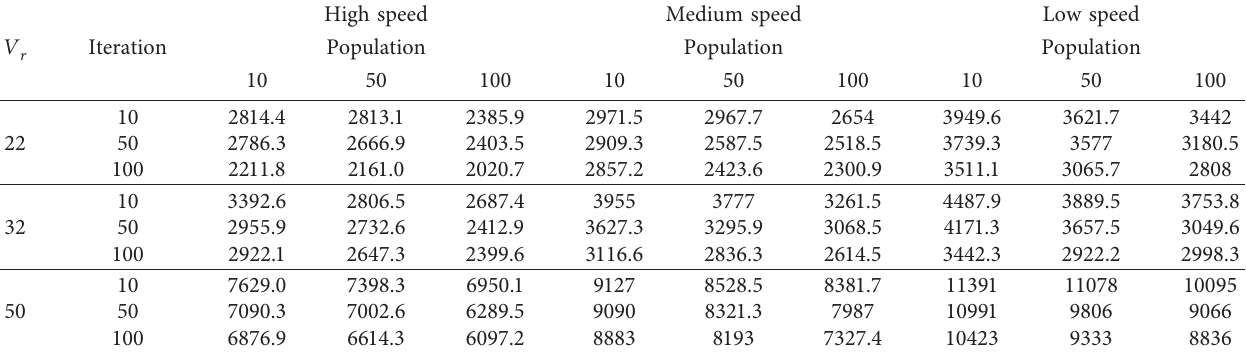
Table 4: Results of the comparison between varied parameter and speed towards costs